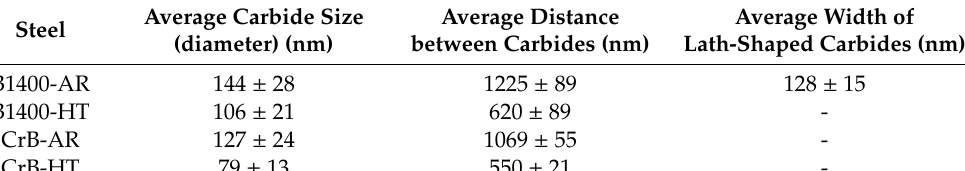
Table 5. The morphological characteristics of carbides in B1400 and CrB steels.